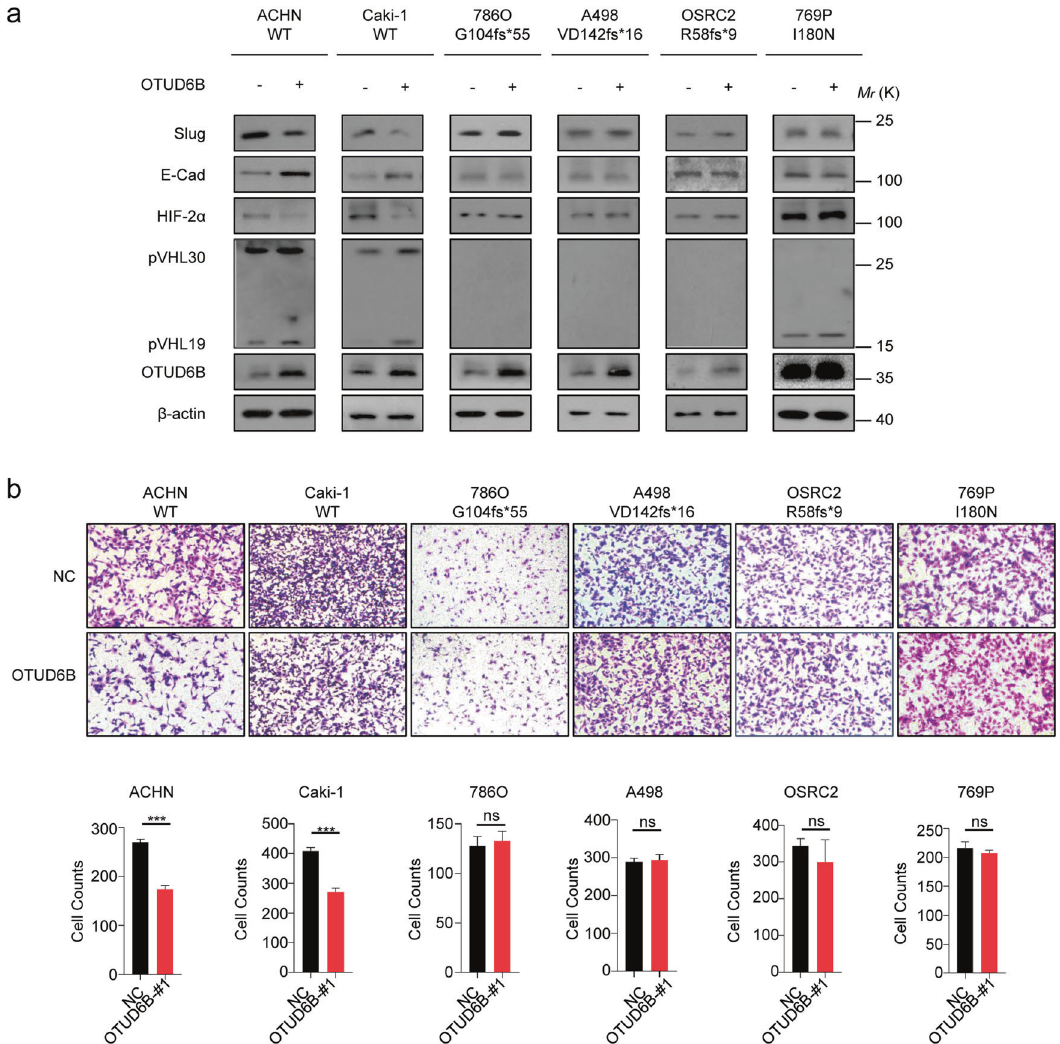
Fig. 3 OTUD6B suppresses ccRCC cell migration. a The lentivirus with ectopic OTUD6B were each infected into ACHN, Caki-1, 786-O, A498, OSRC2, and 769P cell lines, generating ccRCC cells with OTUD6B stable overexpression. Immunoblot assays were conducted with indicated antibodies in ccRCC cell lines with or without OTUD6B overexpression. b Transwell assay was conducted to examine cell migration in ACHN, Caki-1, 786-O, A498, OSRC2, and 769P cells with OTUD6B overexpression or negative control (NC). Cell counts were shown in histogram. Results are displayed as mean ± s.d. n = 3 independent experiments. *** P < 0.001, Student ’ s t ccRCC. According to records from the UMD-VHL mutations database (http://www.umd.be/VHL/) [33], total of 239 VHL missense variants were reported. In Fig. 4a, tumor-derived VHL missense mutations map to the α and β domain. More than ten most frequently mutated residues were labeled. Then, we generated nineteen constructs of tumor-derived VHL mutants, including VHL S65L, V74D, N78S, S80R, P86L, W88L, L89H, Y98H, S111N, G114R, H115N, D121Y, L128H, V130L, I151T, L158P, C162F, R167W, and L178R. Then the stability of these pVHL mutants were detected in cells. The results of western blot showed that compared with negative control, the protein levels of wild type pVHL and the majority of these missense mutants were dramatically increased in ectopic OTUD6B overexpressed cells, except for pVHL I151T mutant (Fig. 4b and c). Further, we treated cells with 10 µg/ml CHX to inhibit protein synthesis and examined the half-life of pVHL mutants in cells. As shown in Fig. 5 a – h, ectopic overexpression of OTUD6B markedly prolonged the half- life of pVHL wild type, as well as S65L, Y98H, C162F, R167W, L178R mutants, but not I151T mutants.